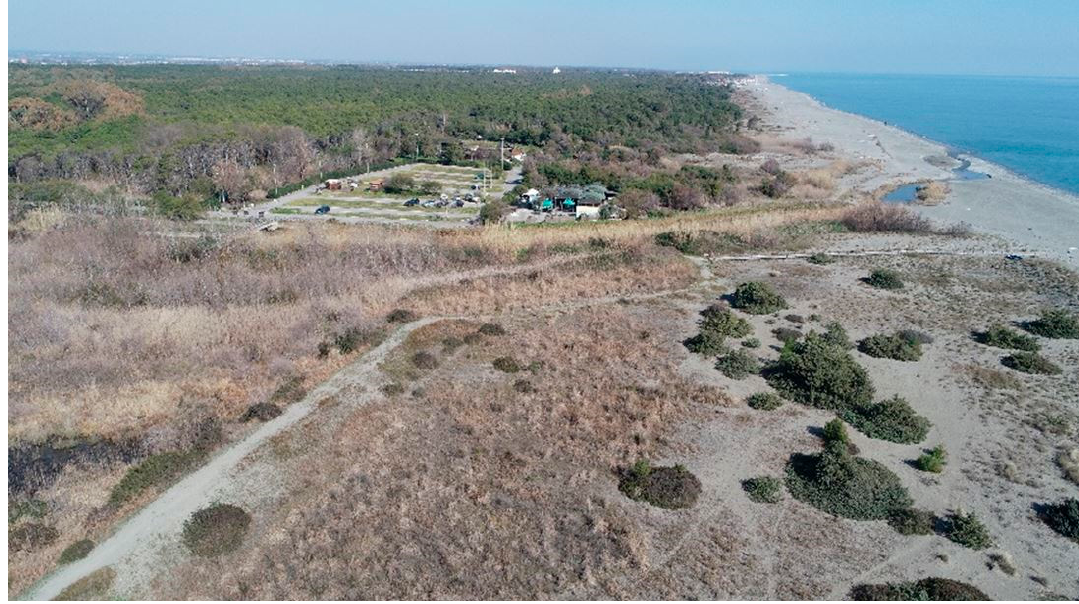
Figure 1. Aerial view of the study area .